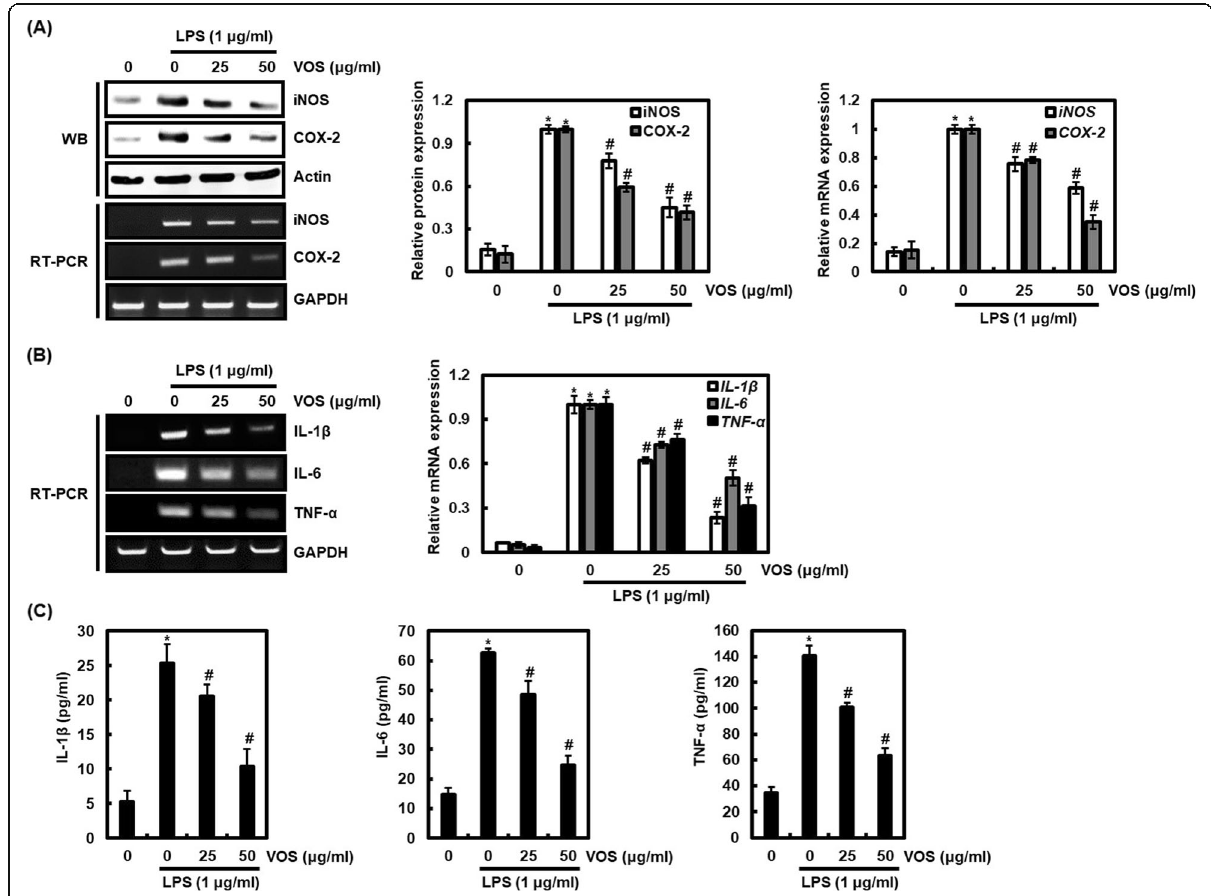
Fig. 4 Effect of VOS on the expression of iNOS, COX-2, IL-1 β , IL-6 and TNF- α in LPS-stimulated RAW264.7 cells. a , b RAW264.7 cells were pretreated with VOS for 6 h and then co-treated with LPS (1 μ g/ml) for 18 h. For Western blot analysis, the cell lysates were subjected to SDS- PAGE and the Western blot was performed using antibodies against iNOS and COX-2. Actin was used as internal control for Western blot analysis. For RT-PCR analysis, total RNA was prepared. GAPDH was used as internal control for RT-PCR. The density of mRNA and protein bands was calculated using the software UN-SCAN-IT gel version 5.1 (Silk Scientific Inc. Orem, UT, USA). *P < 0.05 compared to the cells without the treatment, and # P < 0.05 compared to the cells treated with LPS alone. c RAW264.7 cells were pretreated with VOS for 6 h and then co-treated with LPS (1 μ g/ml) for 18 h. IL-1 β , IL-6 and TNF- α were measured using ELISA